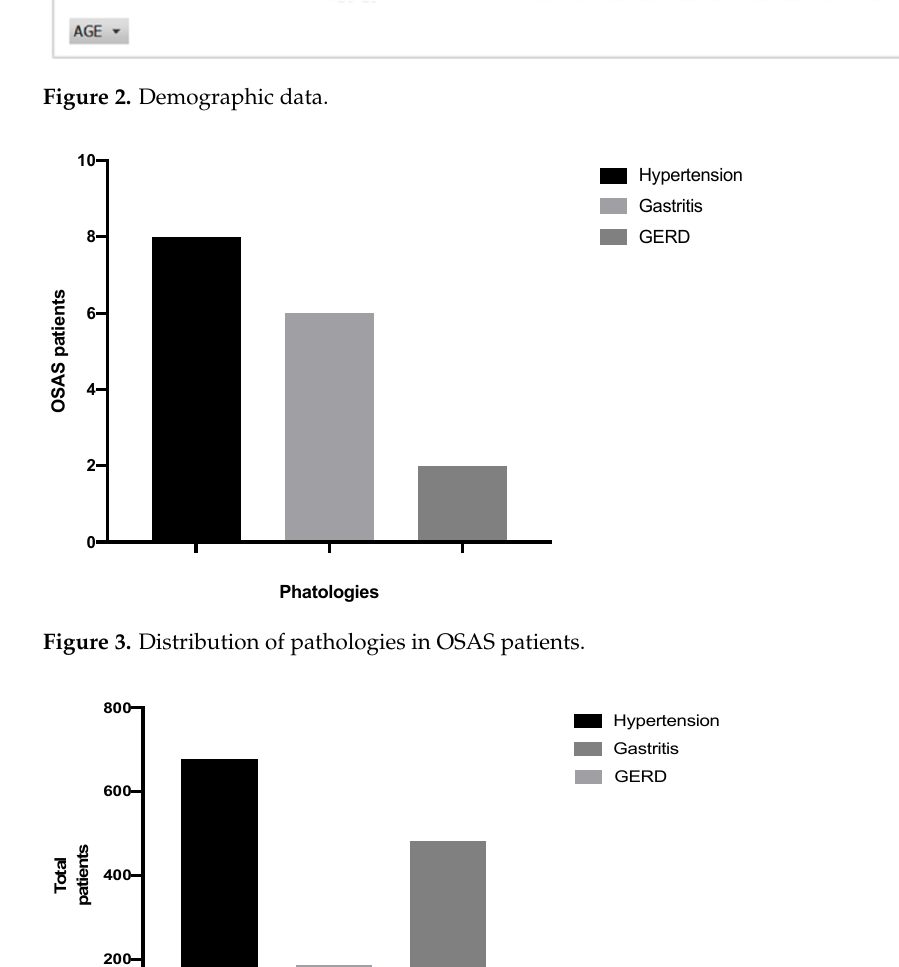
Figure 3. Distribution of pathologies in OSAS patients.